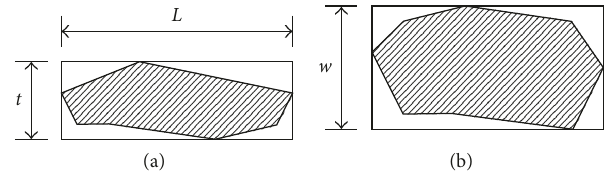
Figure 2: Size index for aggregate particles. (a) Side view; (b) top view.